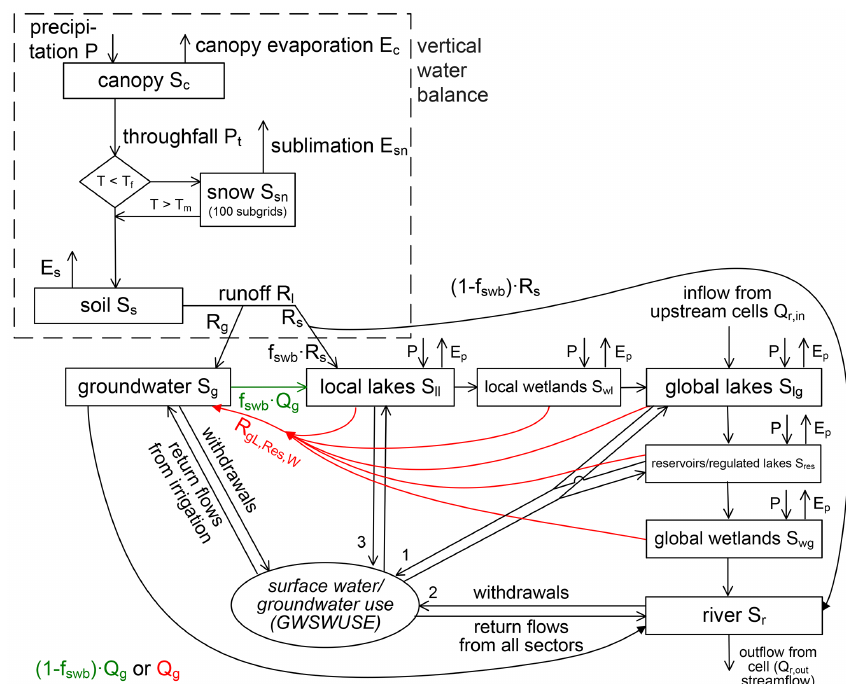
Figure 2. Schematic of WGHM in WaterGAP 2.2d. Boxes represent water storage compartments, and arrows represent water flows. Green (red) color indicates processes that occur only in grid cells with humid ((semi)arid) climate. For details the reader is referred to Sect. 4.2 to 4.8, in which the water balance equations of all 10 water storage compartments are